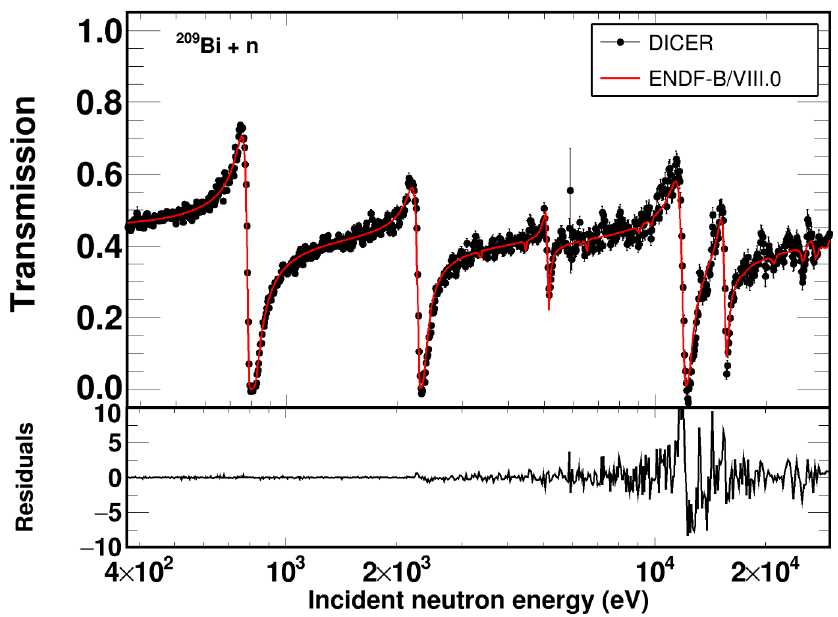
Figure 7. DICER data in comparison with ENDF/B-VIII.0. A satisfactory reproduction was